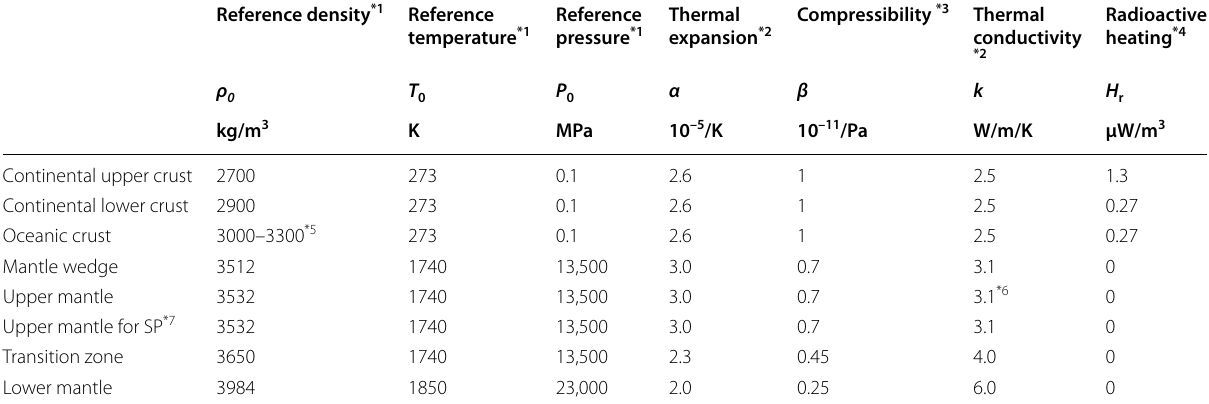
Table 1 Physical properties of